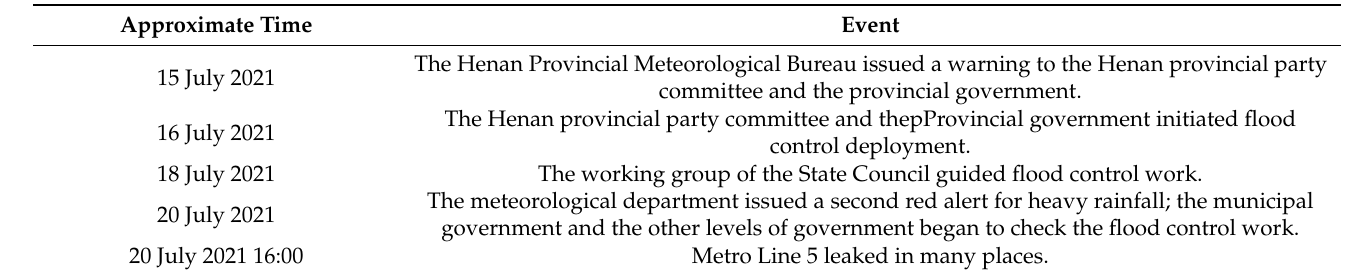
Table 1. The timeline of the events in the Metro Line 5 fatal